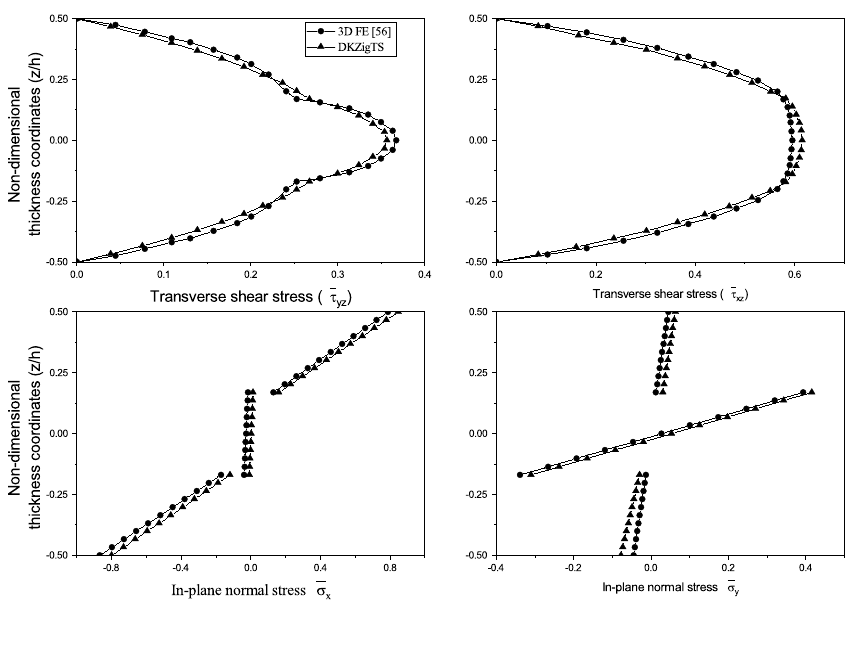
Figure 11: Through the thickness variation of in-plane normal and transverse shear stress for panel ‘A’